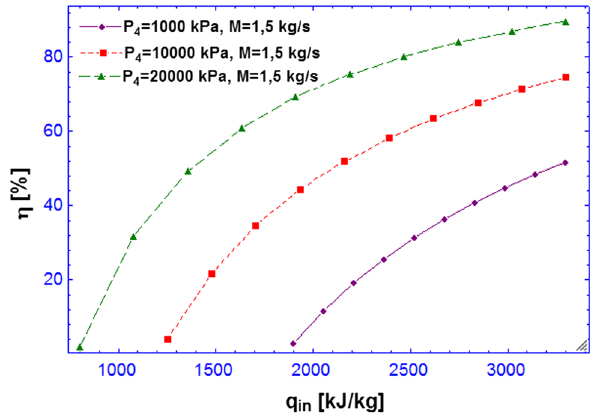
Fig. 10 Efficiency of Rankine cycle versus thermal heat of the RO at different pressures and flow rates of